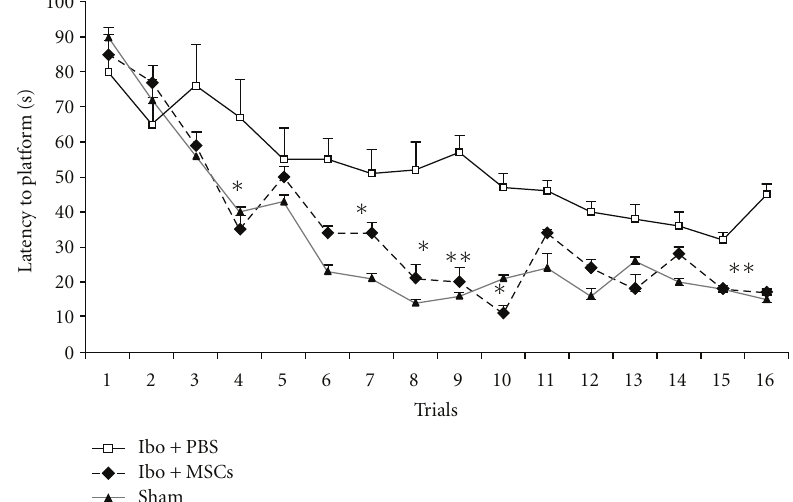
Figure 5: Comparisons of the acquisition performance on the Morris water maze task among the three groups of the Ibo-lesioned rats. The results are the mean latency time traveled per trial. The mean values of the 16 trials for 4 days for each group are shown. Repeated measures of ANOVA for the swimming time among the groups. ∗ P < 0 . 05 and ∗∗ P < 0 . 01 as compared with the corresponding data from the Ibo + PBS group.